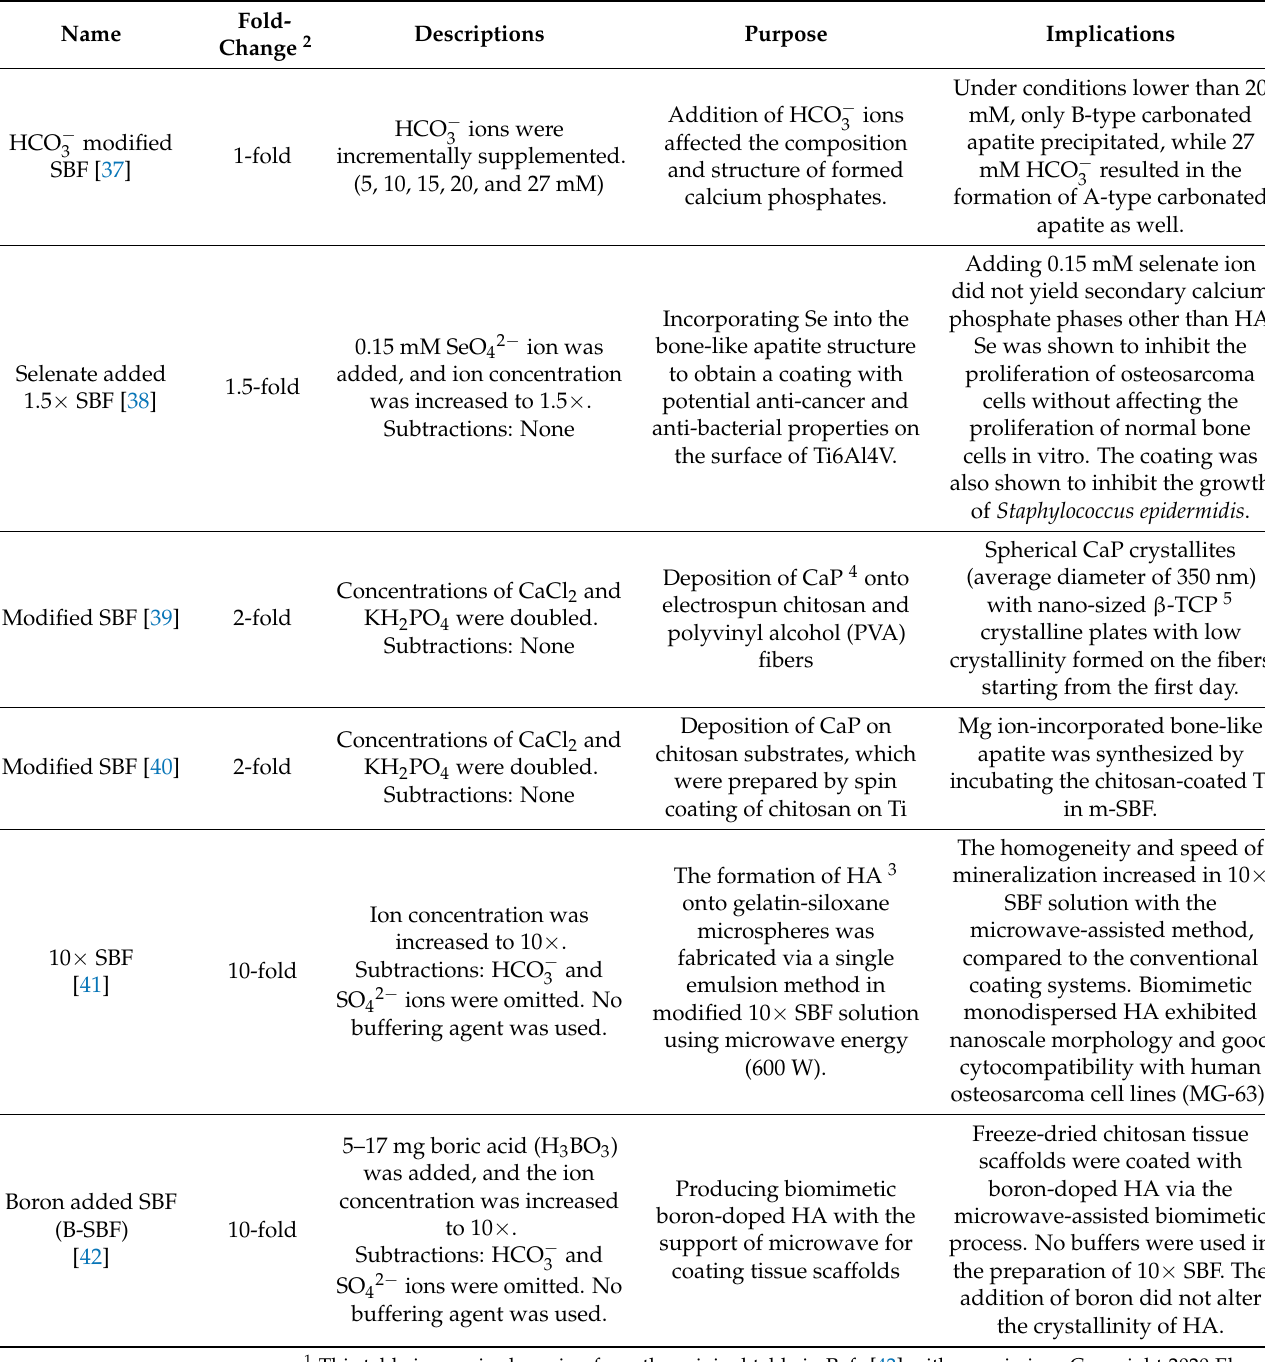
Table 1. Recent examples of using simulated body fluids (SBFs) in different applications 1